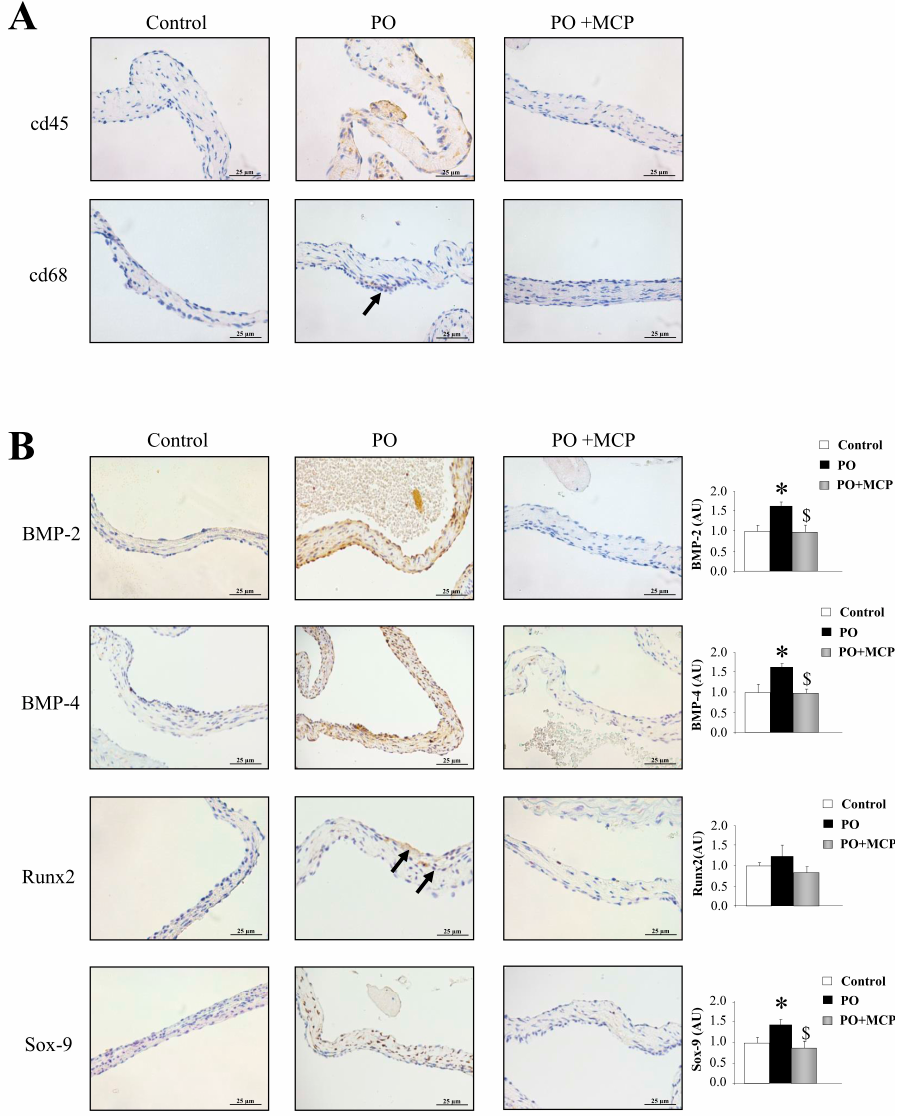
Figure 6. Pharmacological inhibition of Gal-3 reduces AV inflammation and calcification. Representative pictures of AV sections immunostained for cd45 and cd68 ( A ); Immunostaining (left panel) and quantification (right panel) for bone morphogenetic protein (BMP)-2, BMP-4, Runx2, and SRY-homeobOX-like (Sox-9, SRY: Sex-region-determining Y gene) in AVs from controls, PO, and PO + MCP rats ( B ). Arrows show the staining. Histogram bars represent the mean ± SEM of each group of rats. Magnification 40×. (Control rats, n = 7; Pressure Overload rats, PO, n = 7; and Pressure Overload rats treated with MCP, PO + MCP, n = 7). * p < 0.05 vs. control group; $ p < 0.05 vs. PO group.